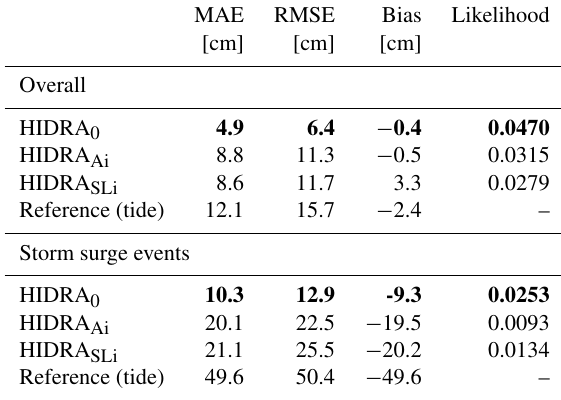
Table 2. HIDRA performance for individual input data sources in terms of mean absolute error (MAE), root mean square error (RMSE) and model bias. Full HIDRA 0 with both input sources is compared with alternatives that use only atmospheric (HIDRA Ai ) or tidal forcing (HIDRA SLi ) as the input. Performance for the at- mospheric tide is provided as reference. Performance is reported on all data as well as on storm surge events only. The best result in each category is denoted in